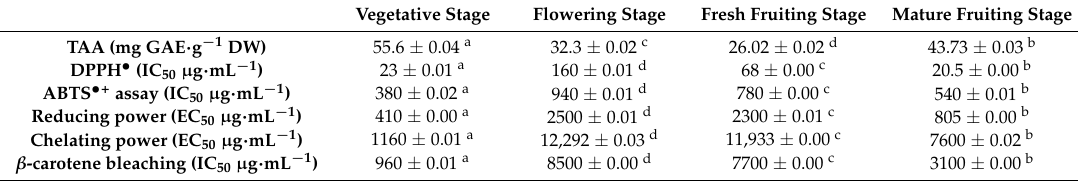
Table 4. Total antioxidant activity (TAA), DPPH • test, ABTS • + assay, reducing power, chelating power and β -carotene bleaching activity) of the hydromethanolic extracts from Retama raetam (Forssk.) Webb shoots of different grown stages.